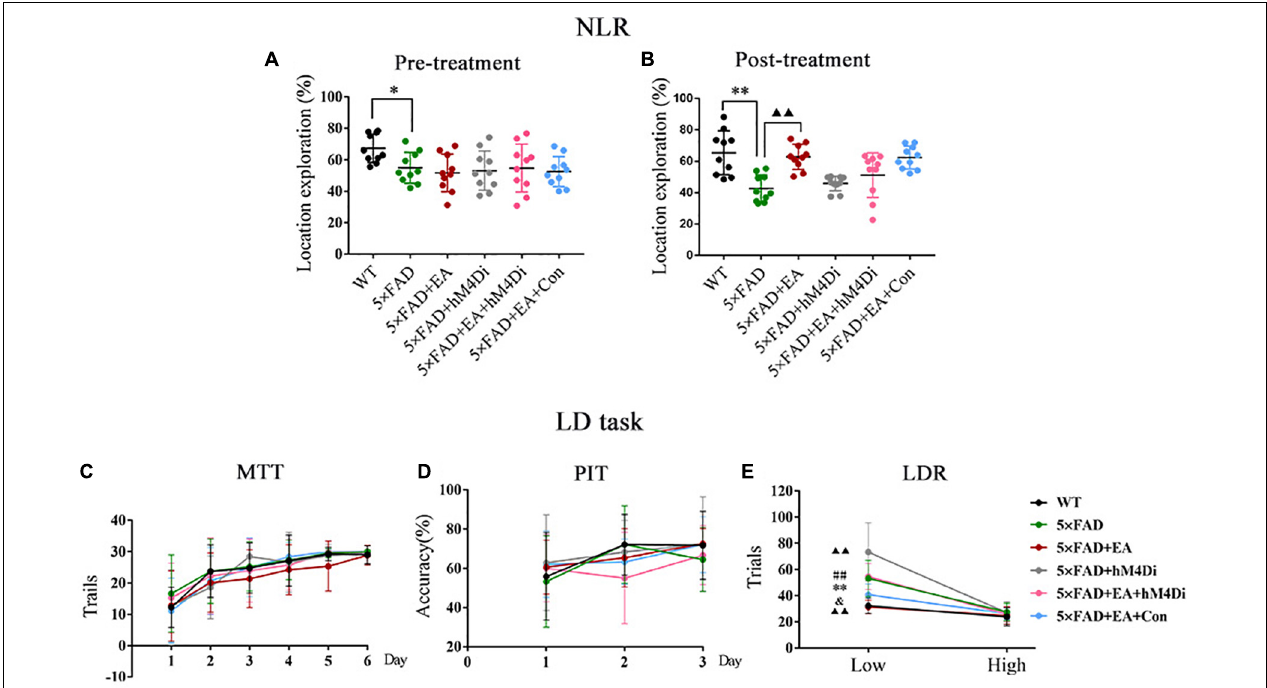
FIGURE 10 | Electro-acupuncture (EA) treatment activates the MS/VDB-DG cholinergic neural circuit improving the pattern separation impairment in 5 × FAD mice. Exploration of mice during novel location recognition (NLR) pre-treatment (A) and post-treatment (B) . Each circle represents a mouse, and n = 10/group. Results of the location discrimination (LD) task are expressed as trails of MIT (C) , the accuracy of PIT (D) , and trails of LDR (E) ( n = 8/group). Data are represented as mean ± SD ( ∗ p < 0.05 and ∗∗ p < 0.01 vs WT group; (cid:78)(cid:78) p < 0.01 vs 5 × FAD group; ## p < 0.01 vs 5 × FAD + EA group; & p < 0.05 vs 5 × FAD + EA + hM4Di group). NLR, novel location recognition; MTT, must touch training; PIT, punish incorrect training; LDR, location discrimination